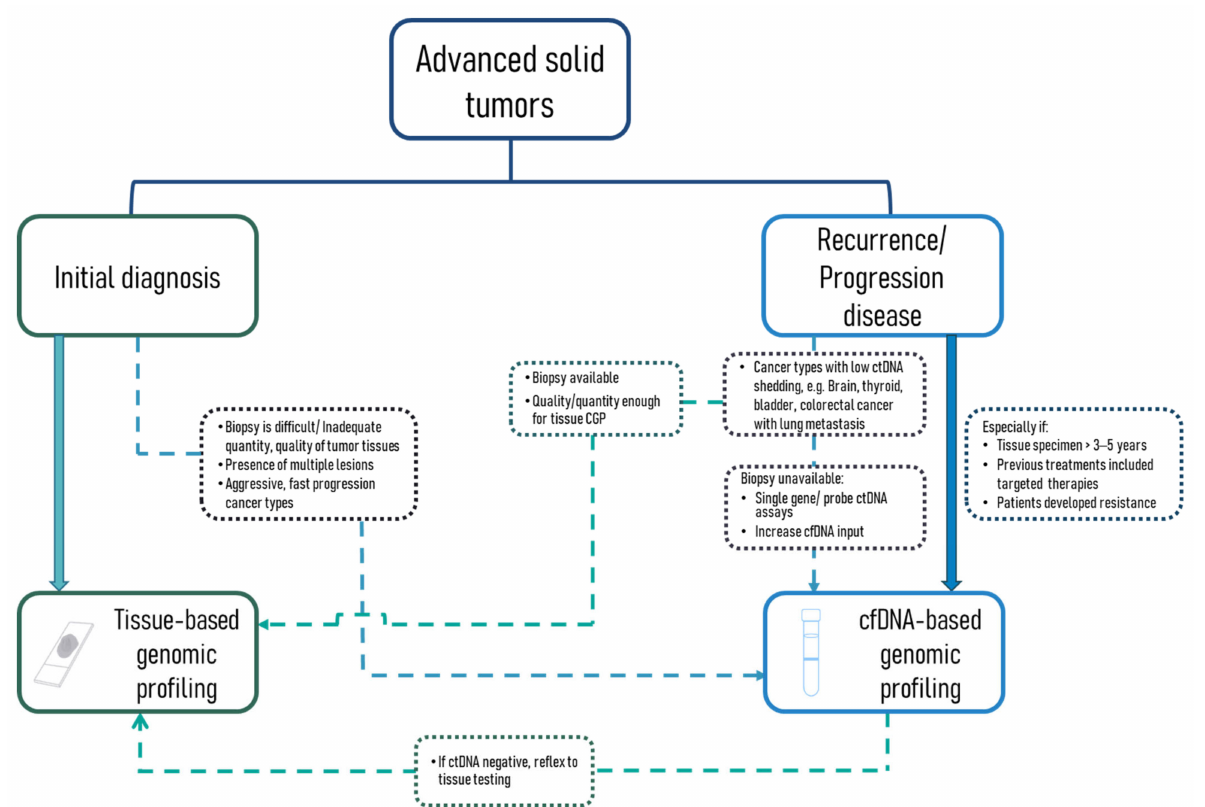
Figure 2. Generalized guidelines for CGP assay selection under different clinical situations. The schema was devised based on recommended guidelines from NCCN, ESMO, ASCO and IASLC together with existing literature. Patients with advanced solid tumors with known FDA-approved targeted therapies should undergo tissue-based genomic profiling for treatment selection. In cases where biopsy and tumor tissues are insufficient or unfeasible, patients present with multiple lesions or patients with aggressive, fast-progression cancers, cfDNA-based genomic profiling should be considered. CGP using cfDNA-based assays should be considered the assay of choice for patients who have developed recurrence or disease progression after targeted therapies. However, for patients with cancer types known to be low shedding of ctDNA and with contemporary tissues available, a tissue-based assay should be preferred. Patients with negative ctDNA results should reflex to tissue testing in all